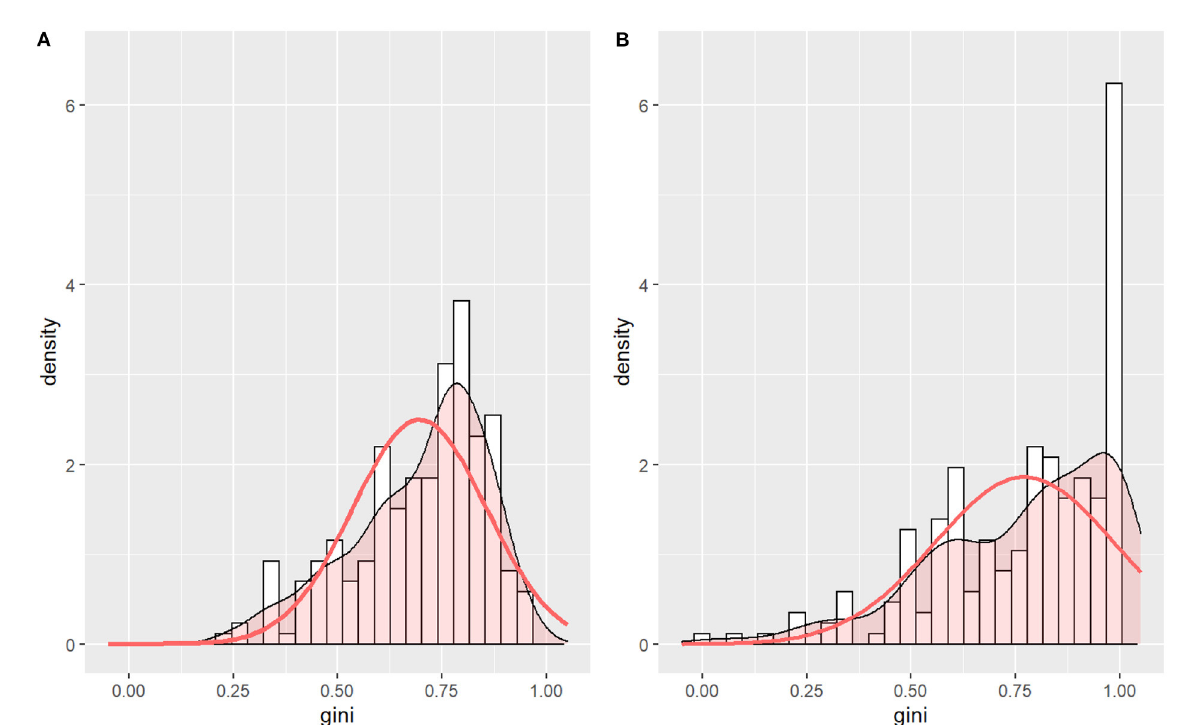
FIGURE4 Gini coefficient of team channels. (A) Considering all users in channels, (B) only considering the participant